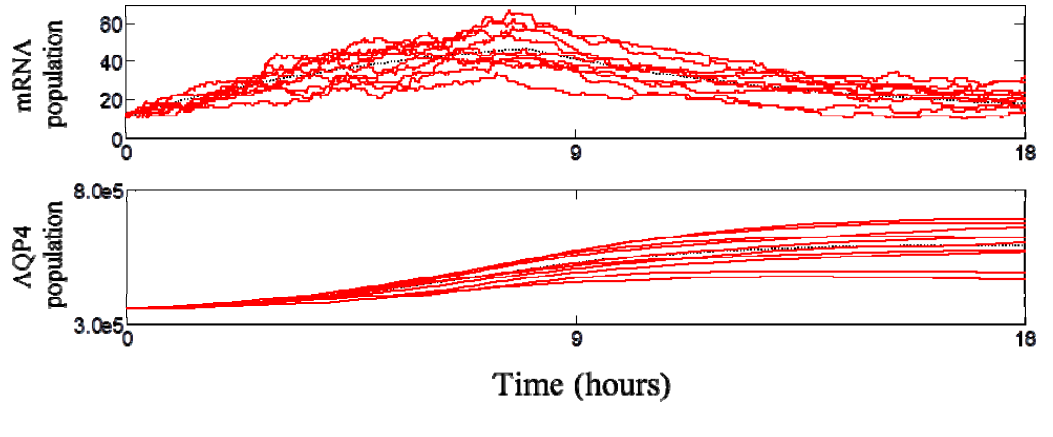
Figure 5. Stochastic simulation results of AQP4 transcripts and proteins after sulforaphane exposure. Each red solid line represents one stochastic realization and dotted black line is the solution of the deterministic simulation. The upregulation of AQP4 normalized to control was 1.48 ± 0.11 at 9 h and 1.68 ± 0.20 at 18